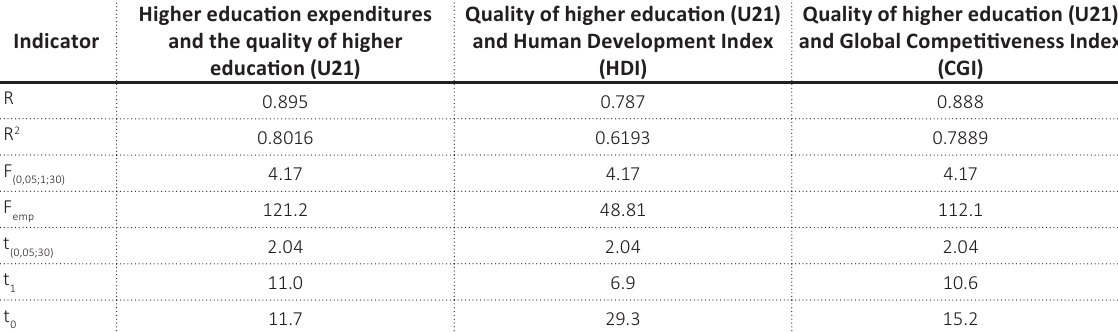
Table 1. Correlation between the amount of higher education expenditures, the quality of higher education, and economic and social